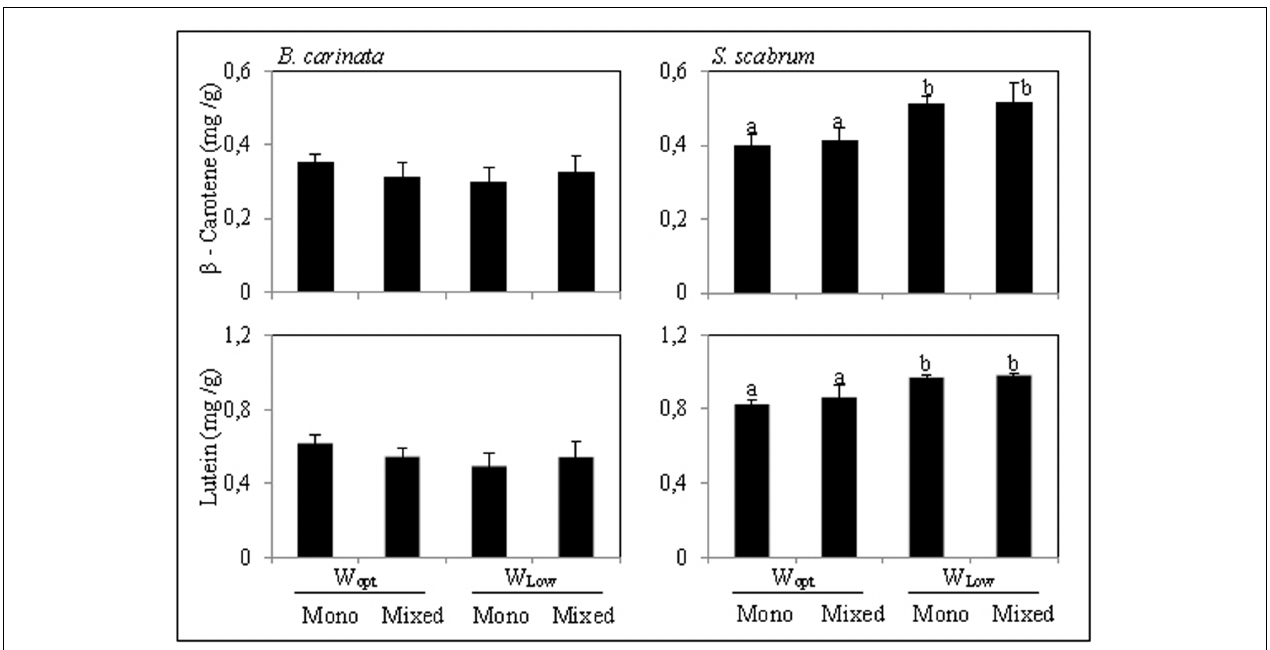
FIGURE 3 | β -Carotene and lutein concentration in B. carinata and S. scabrum leaves (mg/g dry weight). For treatment description, see Table 1 . Presented are the mean values ( n = 4) obtained for each treatment + standard deviation. Bars followed by different letters are significantly different (Tukey HSD test; P ≤ 0.05). TABLE 4 | Chlorophyll A and B concentration in B. carinata and S. scabrum leaves at harvest. Chlorophyll A (mg/g) Chlorophyll B